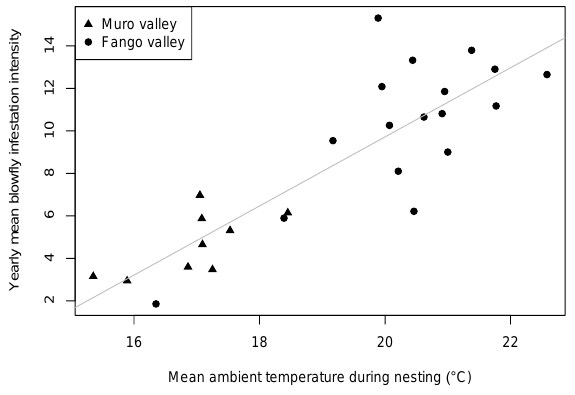
Figure 2. Across years, parasite load correlates positively with ambient temperature during the nestling stage ( i.e. during the developmental period of Protocalliphora larvae) in nests of blue tits on Corsica. Dots represent yearly average